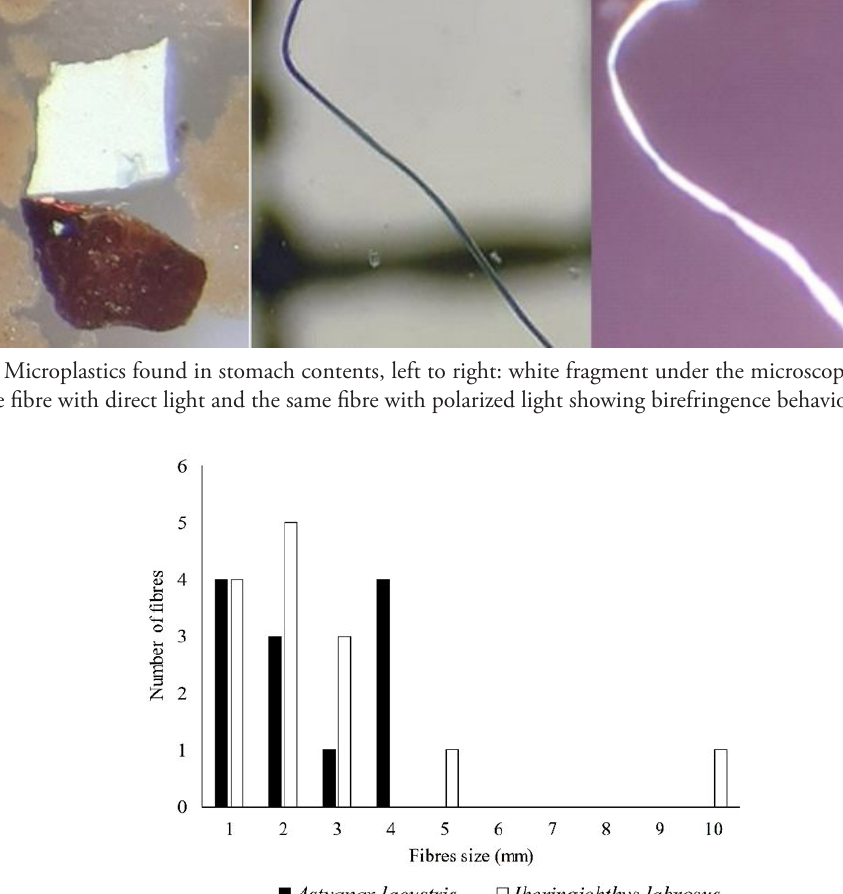
Figure 3. Fibre size frequency found in the gastrointestinal analyses of Astyanax lacustris and Iheringichthys labrosus